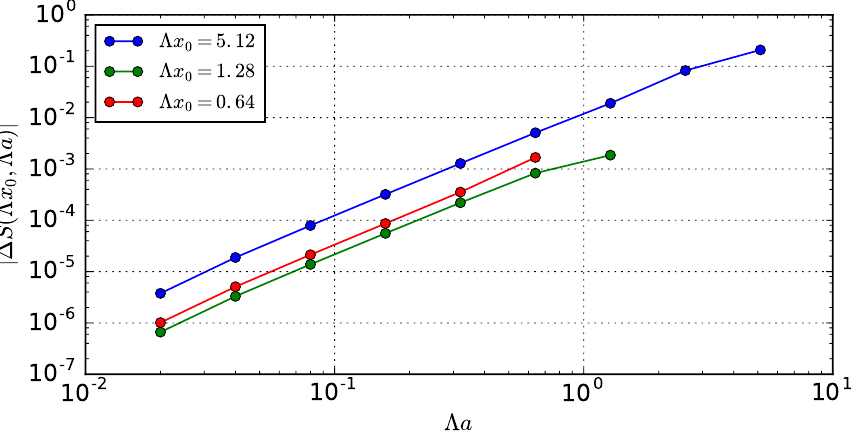
Figure 15 . Plot of the di(cid:11)erence j S ((cid:3) x 0 ; (cid:3) a ) (cid:0) S ((cid:3) x 0 ; (cid:3) a = 0 : 01) j that shows the convergence of this particular value of entropy upon iterative (cid:12)ne-graining of the sampling parameter. The plotted di(cid:11)erence goes to zero approximately quadratically with (cid:3) a